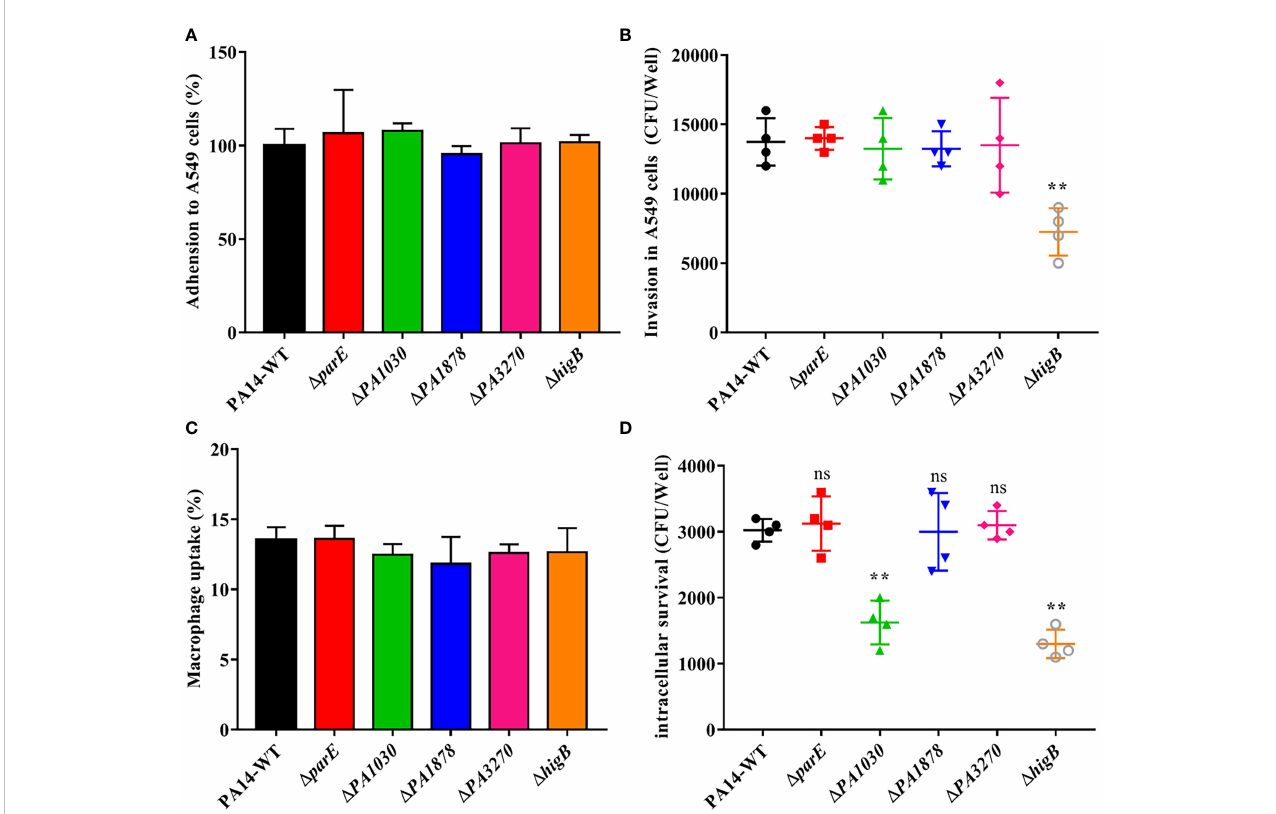
FIGURE 6 Adhesion and invasion in epithelial cell A549 and Macrophage uptake and survival assay of WT P. aeruginosa and mutants. (A) Adhesion and (B) Invasion assay of WT and mutants in human alveolar type II epithelial cell A549. (C) Uptake and (D) % Survival of WT and mutants in RAW264.7 macrophages. Sterile PBS served as negative control. All experiments were performed in triplicates and error bars represent error of the mean (±) for SD. * p < 0.05; ** p < 0.01; *** p < 0.001 by One-way ANOVA statistical test. ns indicates no signi fi cant